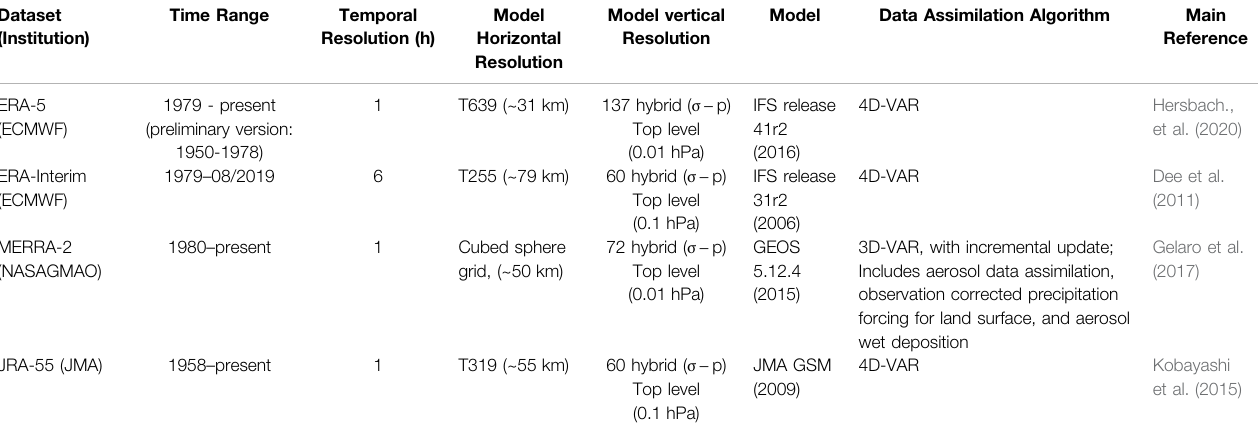
TABLE 1 | Summary of the main characteristics of the selected atmospheric reanalysis datasets. Dataset